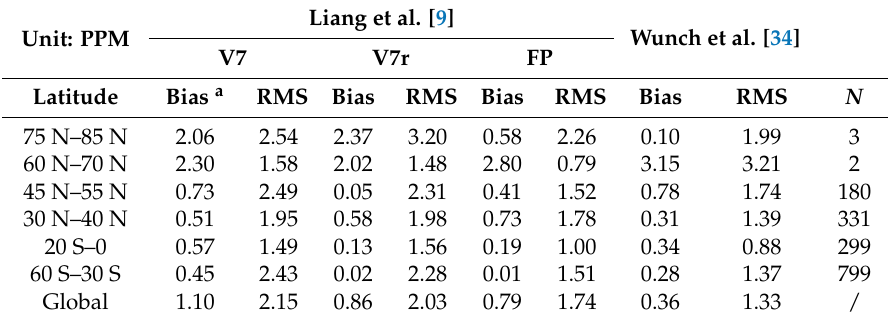
Figure 13. Global atmospheric CO 2 concentrations from 1 January to 11 November 2016, as recorded by National Aeronautics and Space Administration (NASA)’s Orbiting Carbon Observatory-2. Table 4. Validation of XCO 2 from OCO-2 with TCCON.